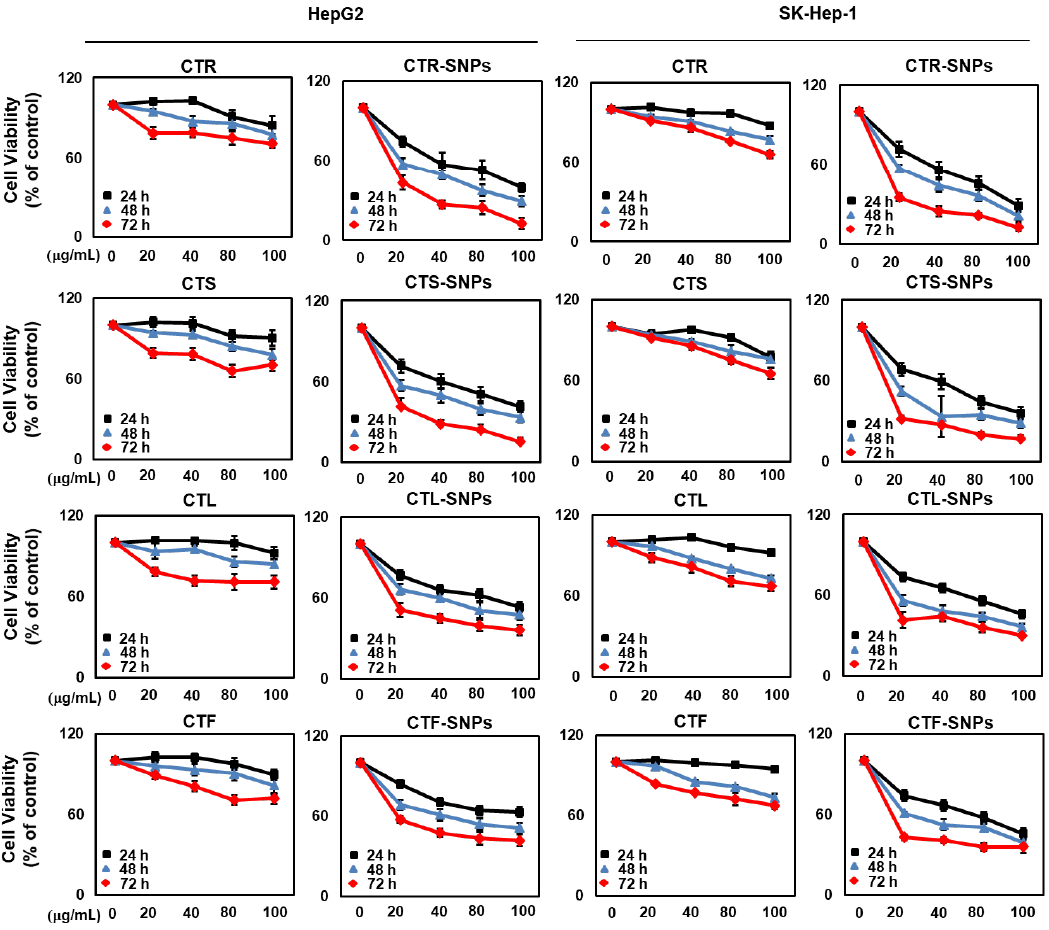
Figure 6. Cytotoxicity of CTR, CTS, CTL, and CTF-SNPs in HepG2 and SK-Hep-1 cells.